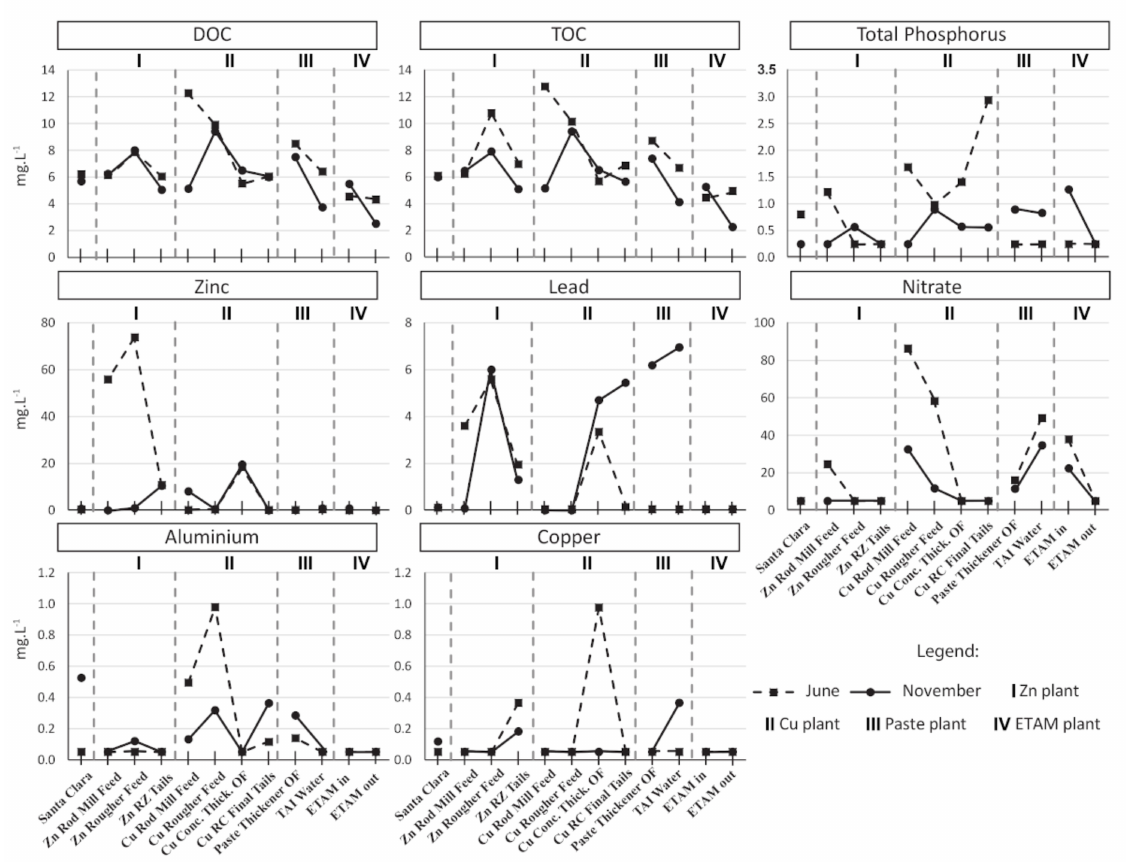
Figure 4. The profiles of minor chemical compounds throughout the plants and water circuit. DOC, dissolved organic carbon; TOC, total organic